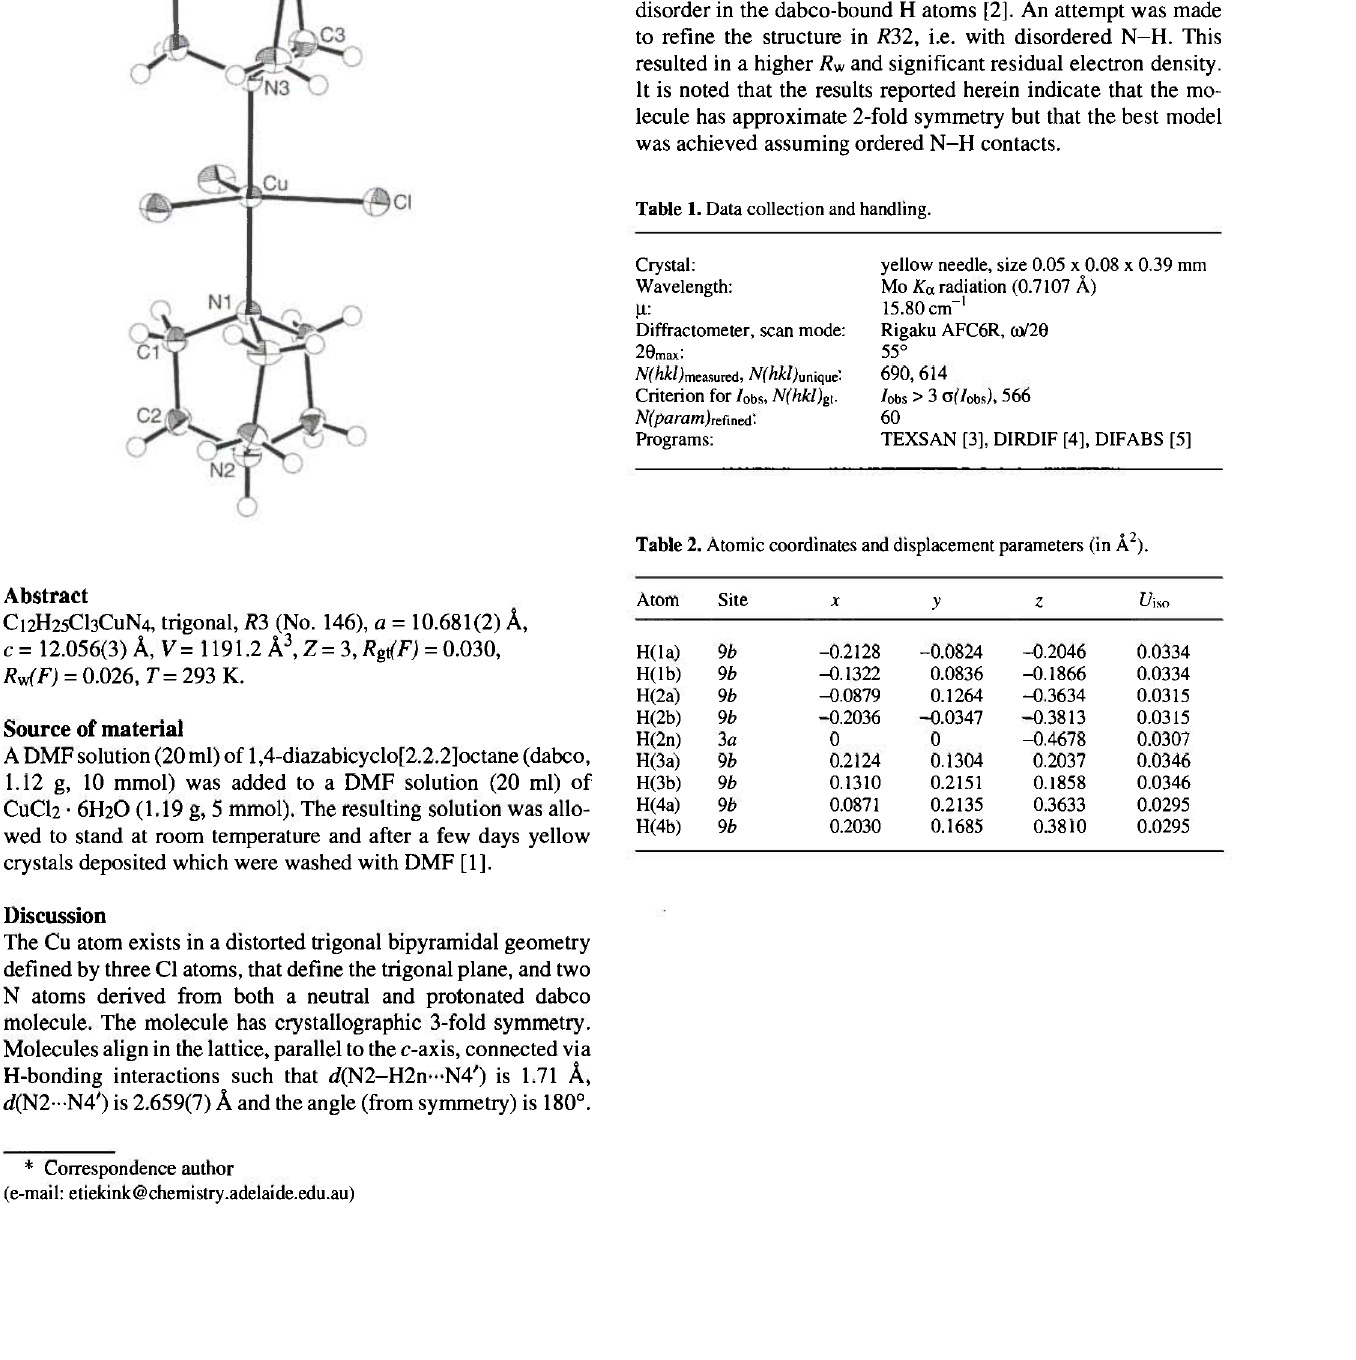
Table 1. Data collection and handling. Crystal: